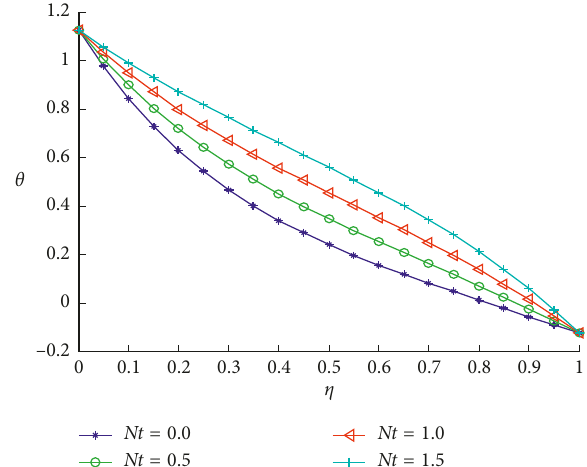
Figure 10: Effect of the thermophoresis parameter on the tem- perature profile when A 2 , S Pr 0 . 5 , Le 1 . 0 , and C (cid:31) (cid:31) (cid:31) (cid:31) 0 . 05. (cid:31)